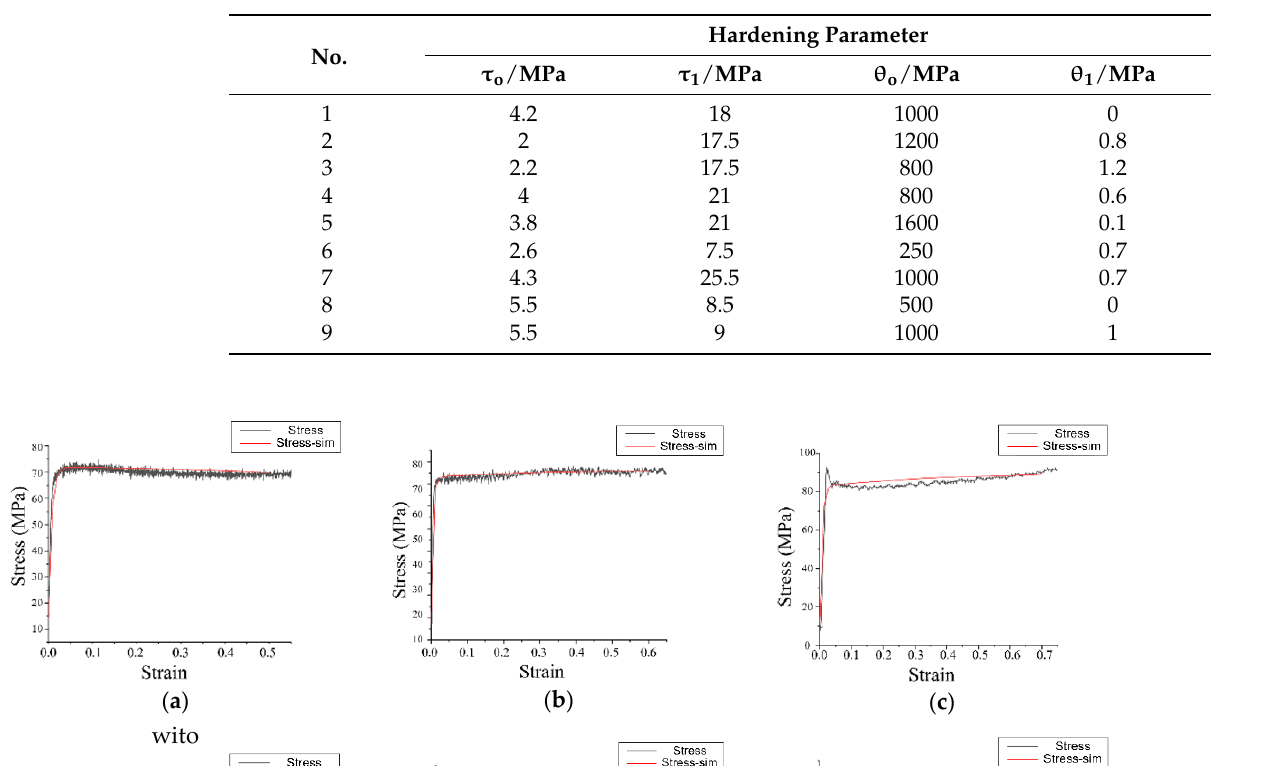
Table 3. Material hardening parameters in simulation.